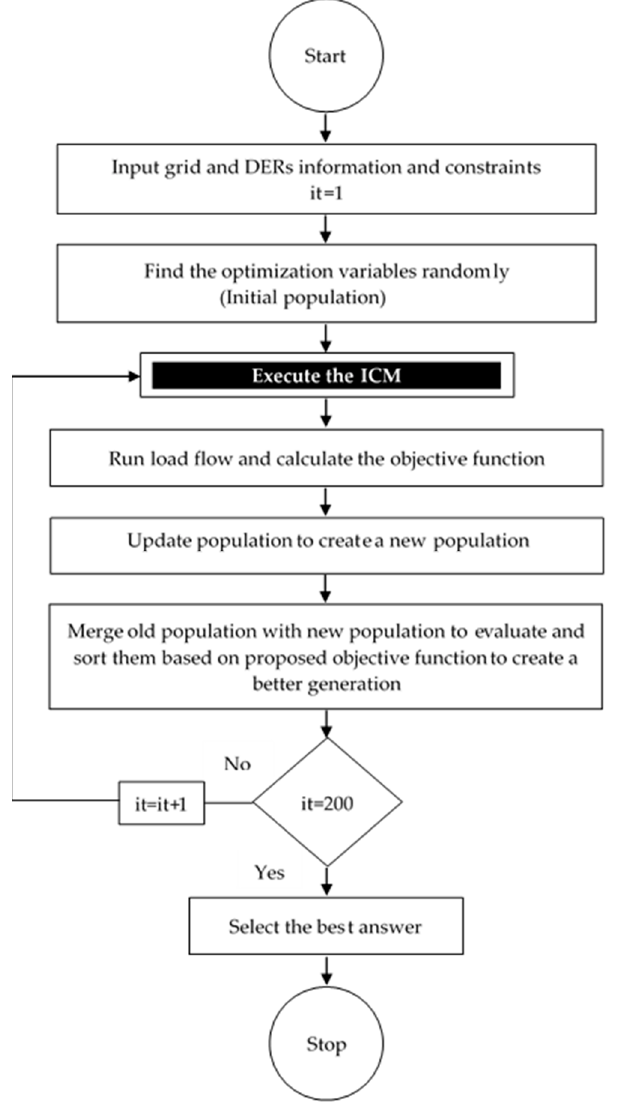
Figure 1. Flowchart of the optimization process.